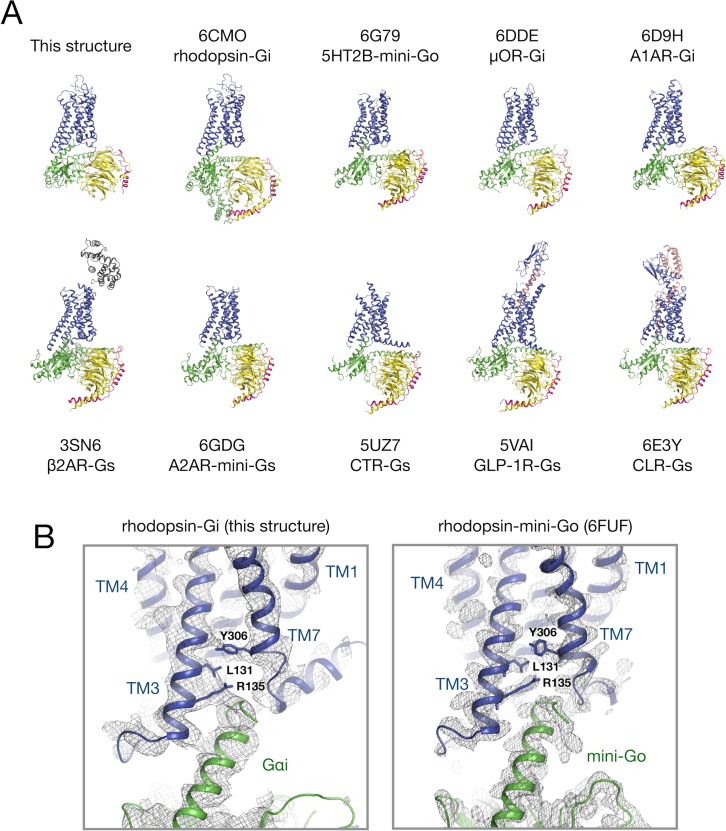
Comparison of the bovine rhodopsin-Gi complex to the other GPCR-G protein complexes.(A) The complex structures are aligned to the Cα atoms of the rhodopsin-Gi complex (receptor – blue; Gα – green; Gβ – yellow; Gγ – magenta; peptide ligand – salmon). (B) Binding interface between the receptor and the Gα α5 helix in the structures of rhodopsin-Gi and rhodopsin-mini-Go (PDB id: 6FUF). Rhodopsin and G proteins are colored in blue and green, respectively. The side chains of Leu1313.46, Arg1353.50, Tyr3067.53 are plotted in sticks and the density maps are shown as gray meshes.